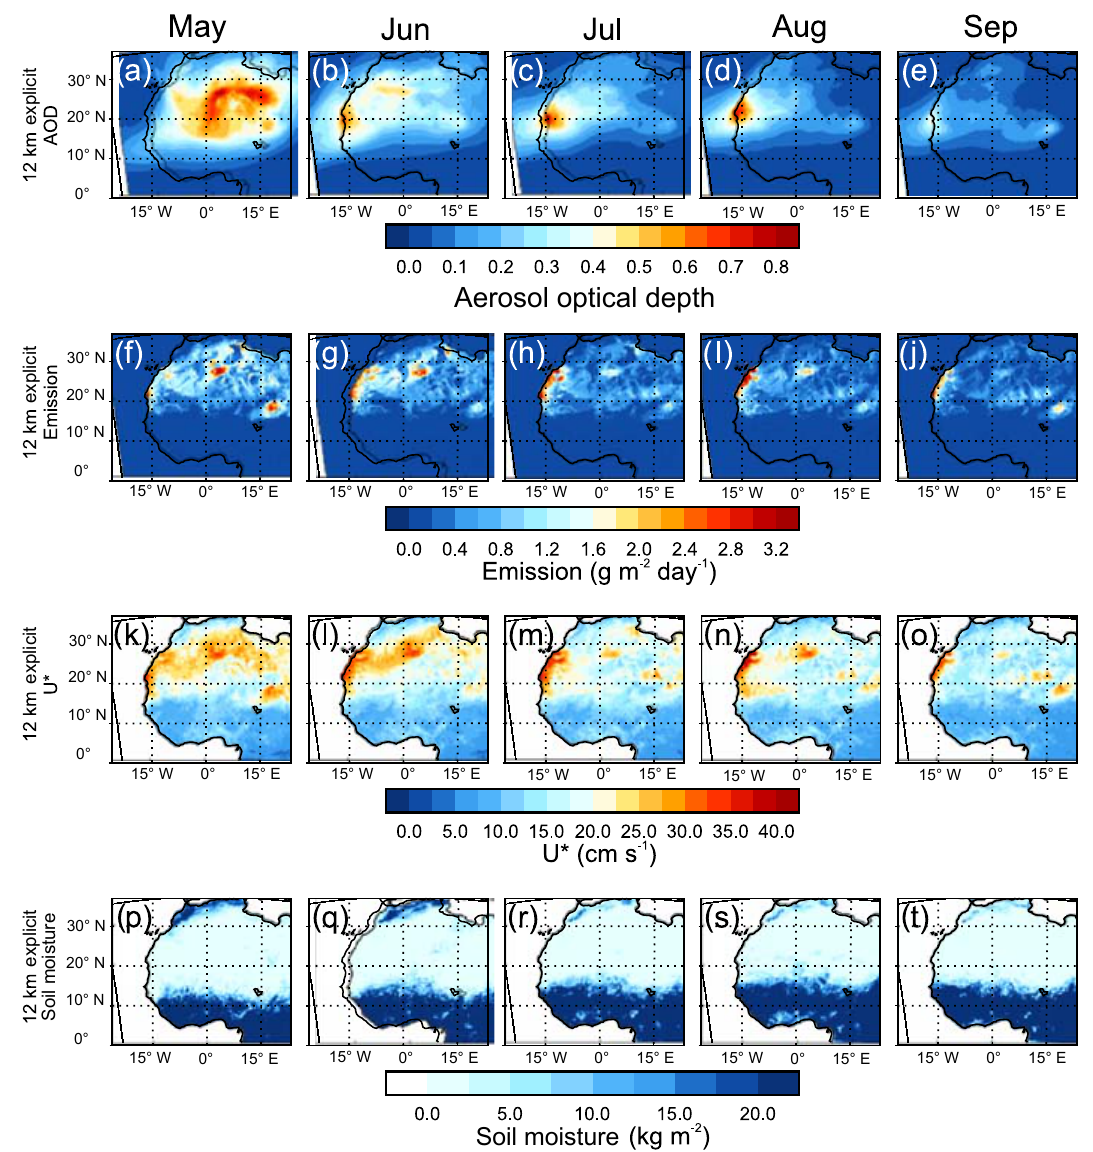
Figure 4. Monthly mean (May–September) maps showing (a–e) aerosol optical depth (AOD), (f–j) dust emission, (k–o) friction velocity over bare soil ( U ∗ ) and (p–t) soil moisture from the 12km simulation with explicit convection